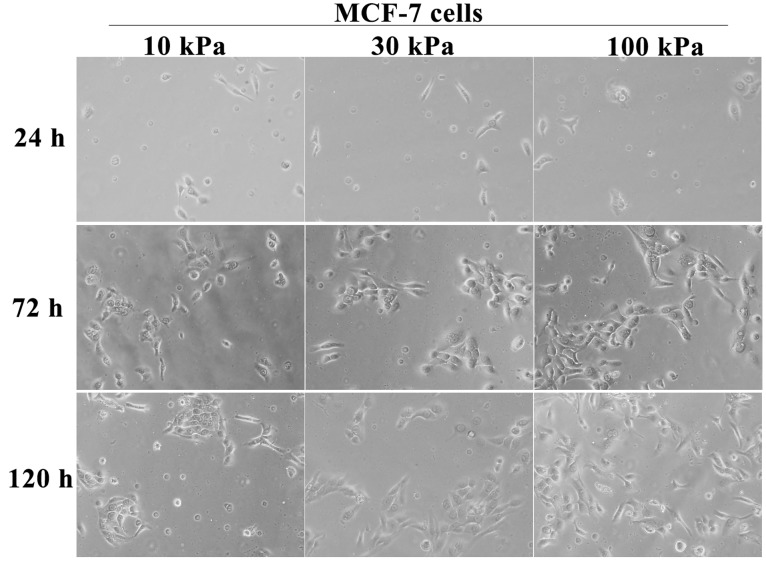
Growth characteristics and morphology of cells grown on different rigidity silicone substrates, EY = 10, 30 and 100 kPa (×400). EY: the Young’s modulus.